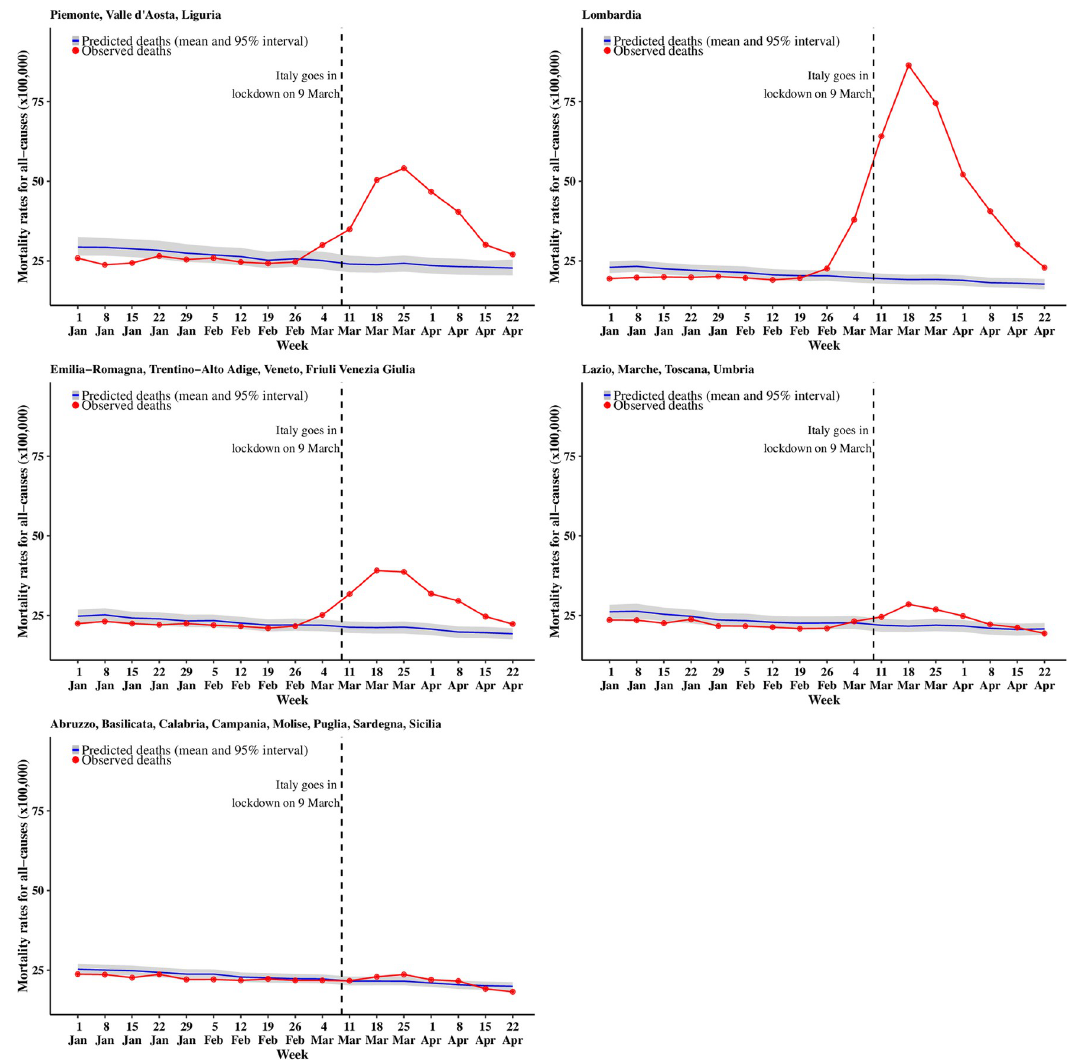
Fig 1. Trend for all cause mortality (males). The blue curve shows the posterior mean predicted from the 2016–2019 model, while the gray ribbon describes the posterior 95% interval; the observed number of deaths for 2020 are in